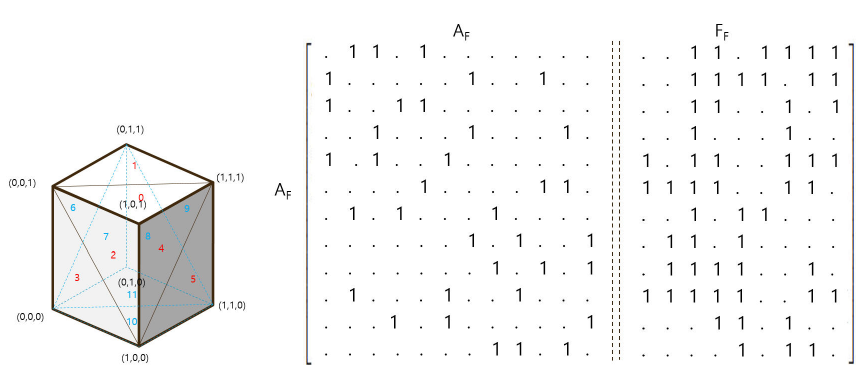
Figure 5. Face adjacency ( A F ) and face feature ( F F : position value of 3 vertices x/y/z) of a sim- ple